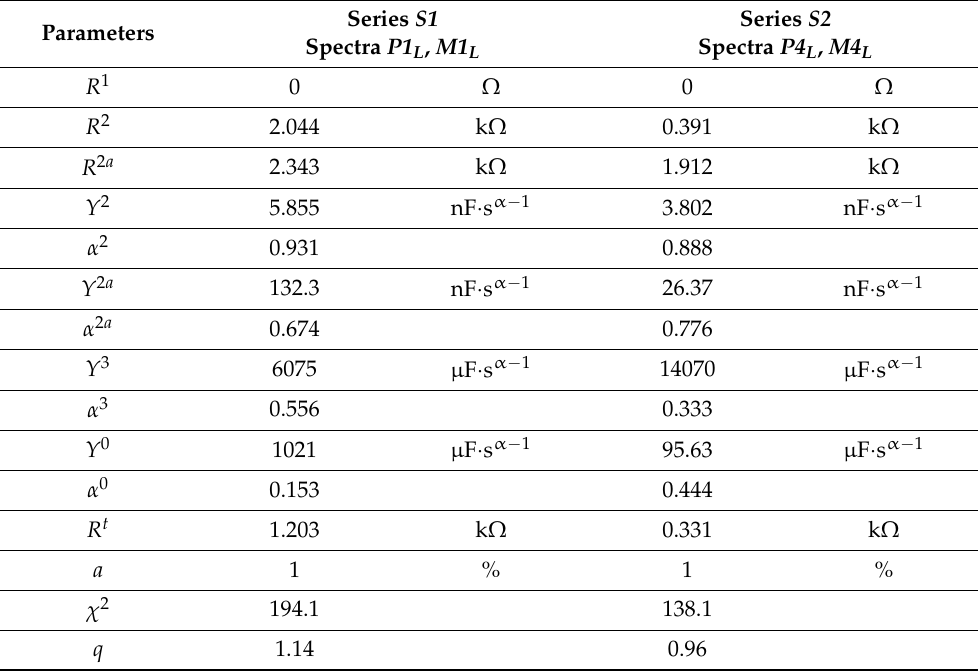
Table A2. Electrochemical parameters of initial spectra, introduced into Formulas for the 3D model to simulate the effect of a varying length L E of the counter electrode and statistical evaluation of matching the model spectrum to the empirical